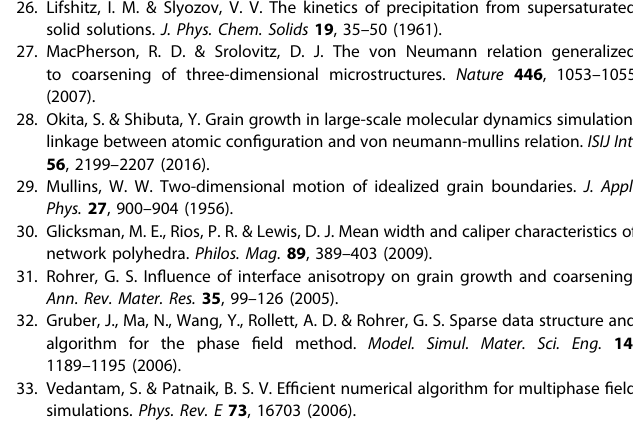
algorithm for the phase fi eld method. Model. Simul. Mater. Sci. Eng. 14 , 1189 – 1195